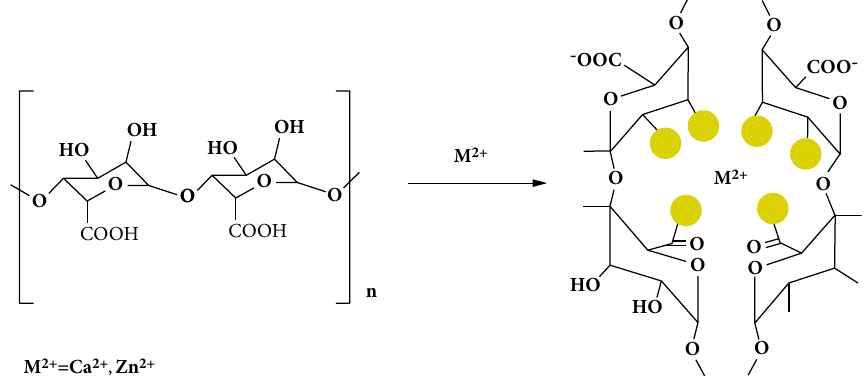
Figure 1: The “egg-box” model and the yellow circles represent the oxygen atoms involved in the coordination of the M 2+